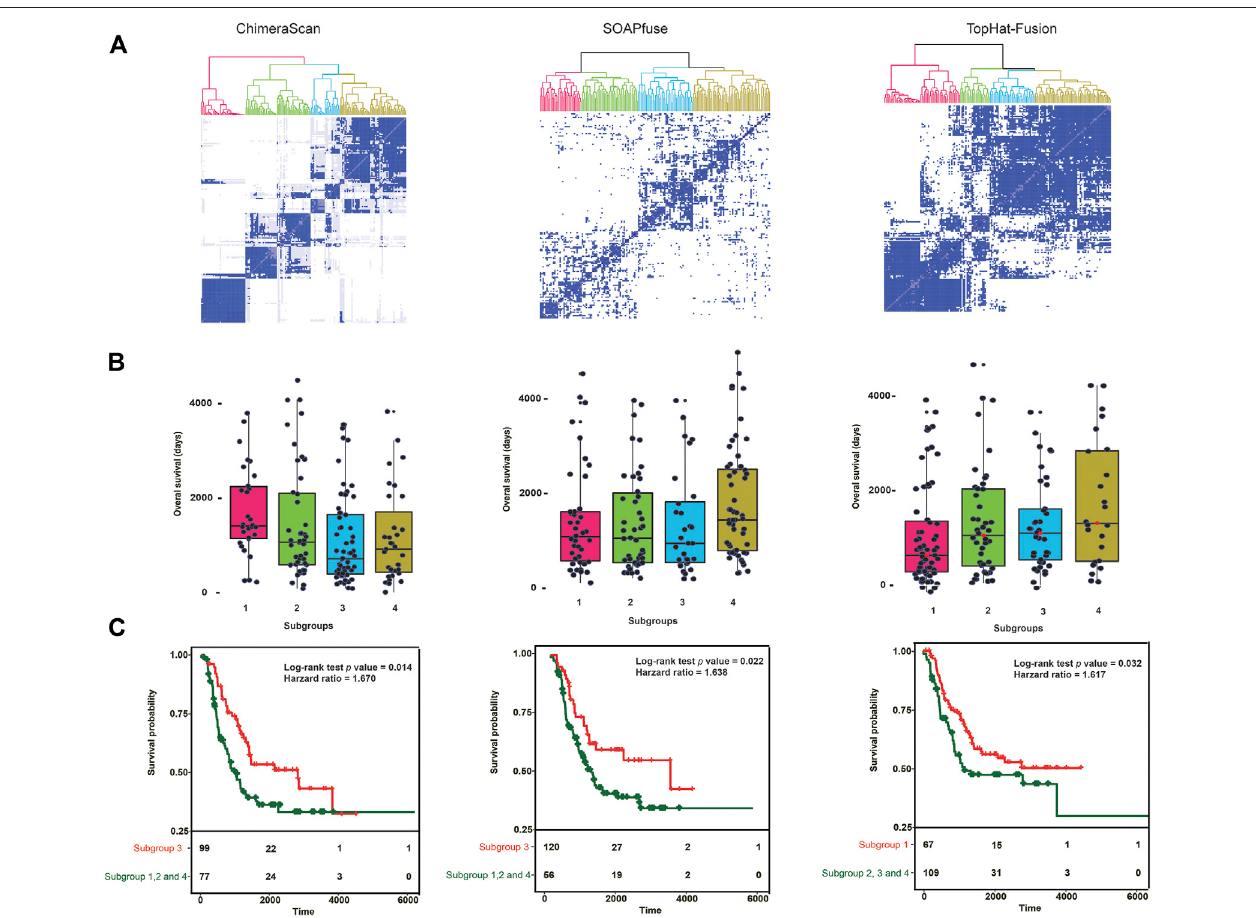
FIGURE3 | Gene fusion pro fi le-based patient strati fi cation and survival analysis: (A) hierarchical clusteranalysis(HCA) forrede fi ning patientsubgroups inhigh-risk NB patient groups for each fusion detection algorithm. First, patient assignment matrices were generated from average results of 500 runs with nonnegative matrix factorization(NMF)withpatientgenefusionpro fi les.Then,theHCAwasperformedonthepatient assignmentmatricestorede fi nethepatient groups.Thecolordenotes therede fi ned patient groups; (B) Theoverallsurvivaltime(Days) ofpatientsintherede fi ned patientsubgroups.Thesubgroup withlowestmedian survivaltime was consideredastherede fi nedhigh-riskgroup; (C) Kaplan-Meiersurvivalanalysiswasconductedbetweentherede fi nedhigh-risksubgroupsandthecombinationofother subgroups. Log-Rank p value and the hazard ratio was calculated.